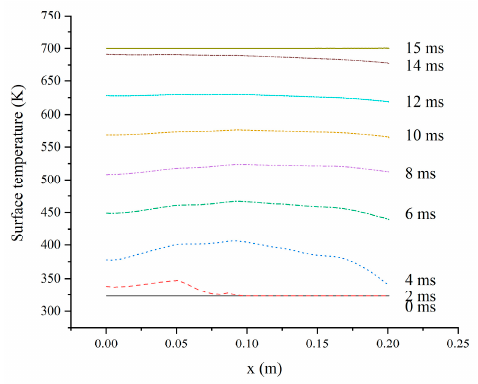
Figure 7. Propellant surface temperature at different times.